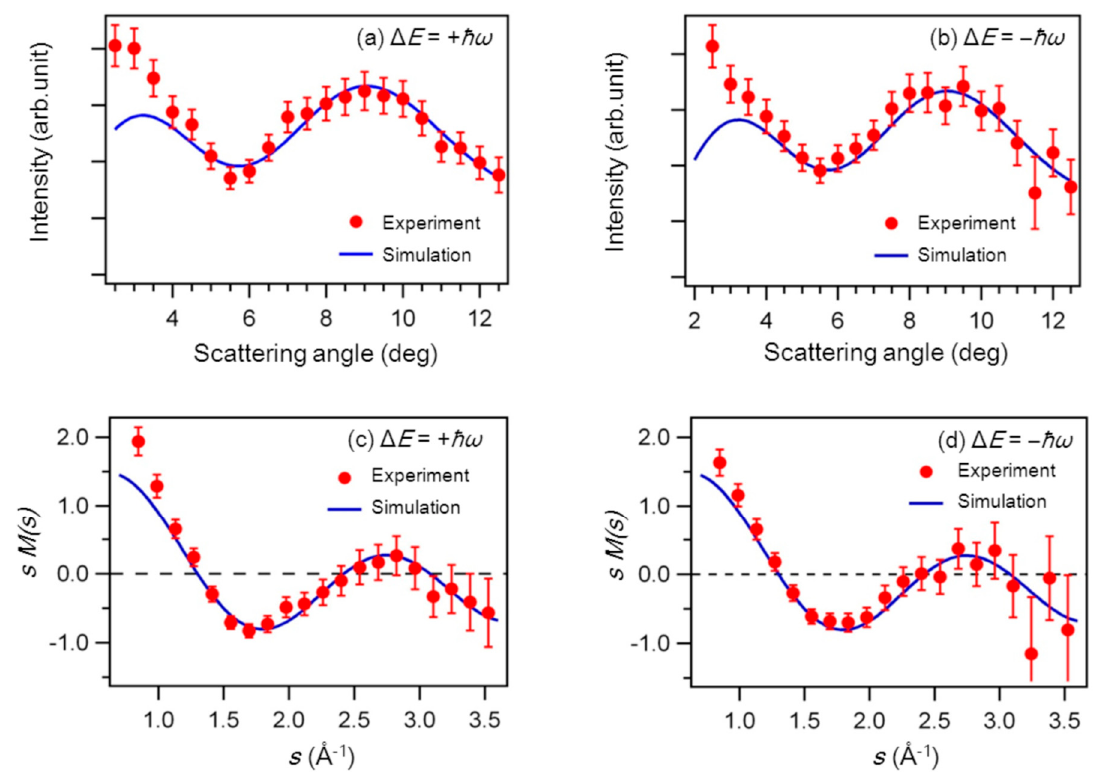
Figure 12. (Top panels) Laser-assisted electron diffraction patterns of CCl 4 at ( a ) ∆ E = + ħω and ( b ) ∆ E = – ħω . (Bottom panels) Modified molecular scattering intensities calculated from the LAED patterns at ( c ) ∆ E = + ħω and ( d ) ∆ E = – ħω [82]. Red filled circles are the experimental data. Blue solid curves are the results of the simulation. The kinetic energy of the incident electrons was 1 keV, and the laser-field parameters were Δ t = 520 fs, λ = 800 nm, and I = 6 × 10 11 W/cm 2 . Reproduced from Y. Morimoto, R. Kanya, and K. Yamanouchi, “Laser-assisted Electron Diffraction for Probing Femtosecond Nuclear